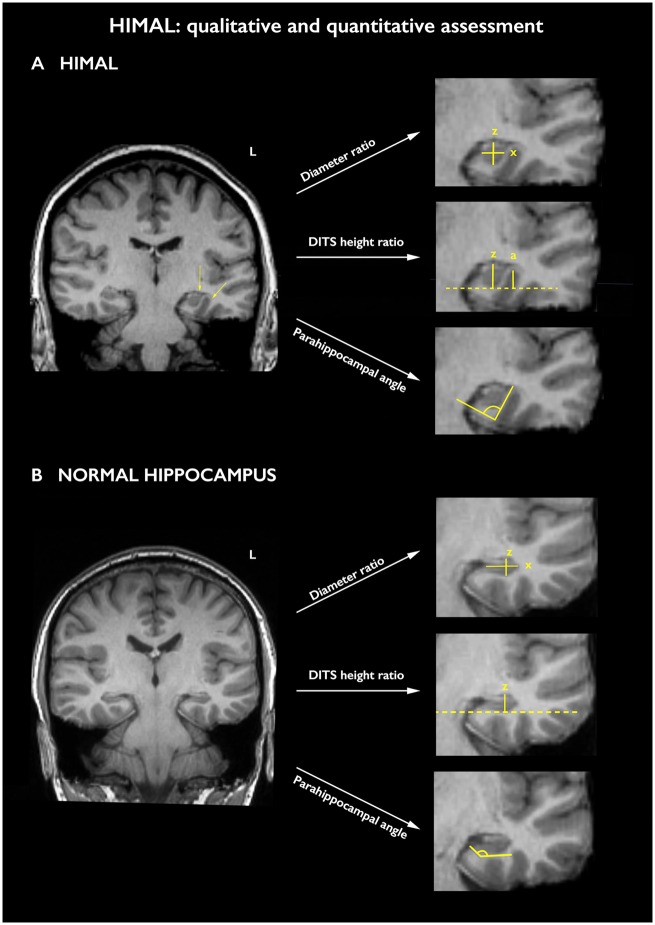

Qualitative and quantitative assessment of the hippocampus. (A) An example of a left hippocampus with HIMAL, as evidenced by a round hippocampal shape, loss of the lateral hippocampal convexity, the latter implying an enhanced radius of curvature (left-hand arrow), and verticalization of the DITS (right-hand arrow). The right hippocampus does not exhibit clear-cut features of HIMAL. (B) An example of a subject with normal hippocampi. The right-hand parts of A and B provide demonstrations of the three quantitative measures implemented in the study: diameter ratio, i.e. z divided by x; DITS height ratio, i.e. z divided by a, or value equal to zero in the absence of overlap between DITS and hippocampus, resulting in no measurable a; and parahippocampal angle, for a hippocampus with HIMAL (A) and for a normal hippocampus (B). See main text for details.